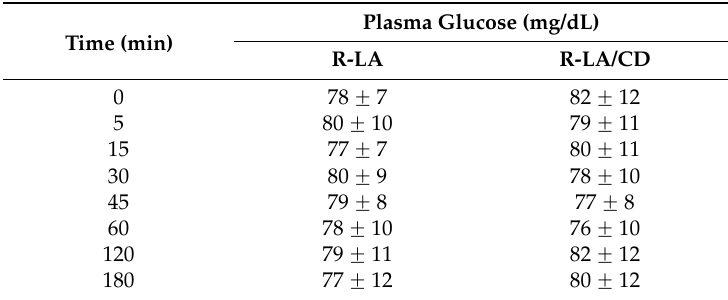
Table 2. Plasma glucose level in the subjects after a single oral administration of 600 mg of R-LA or 6 g of